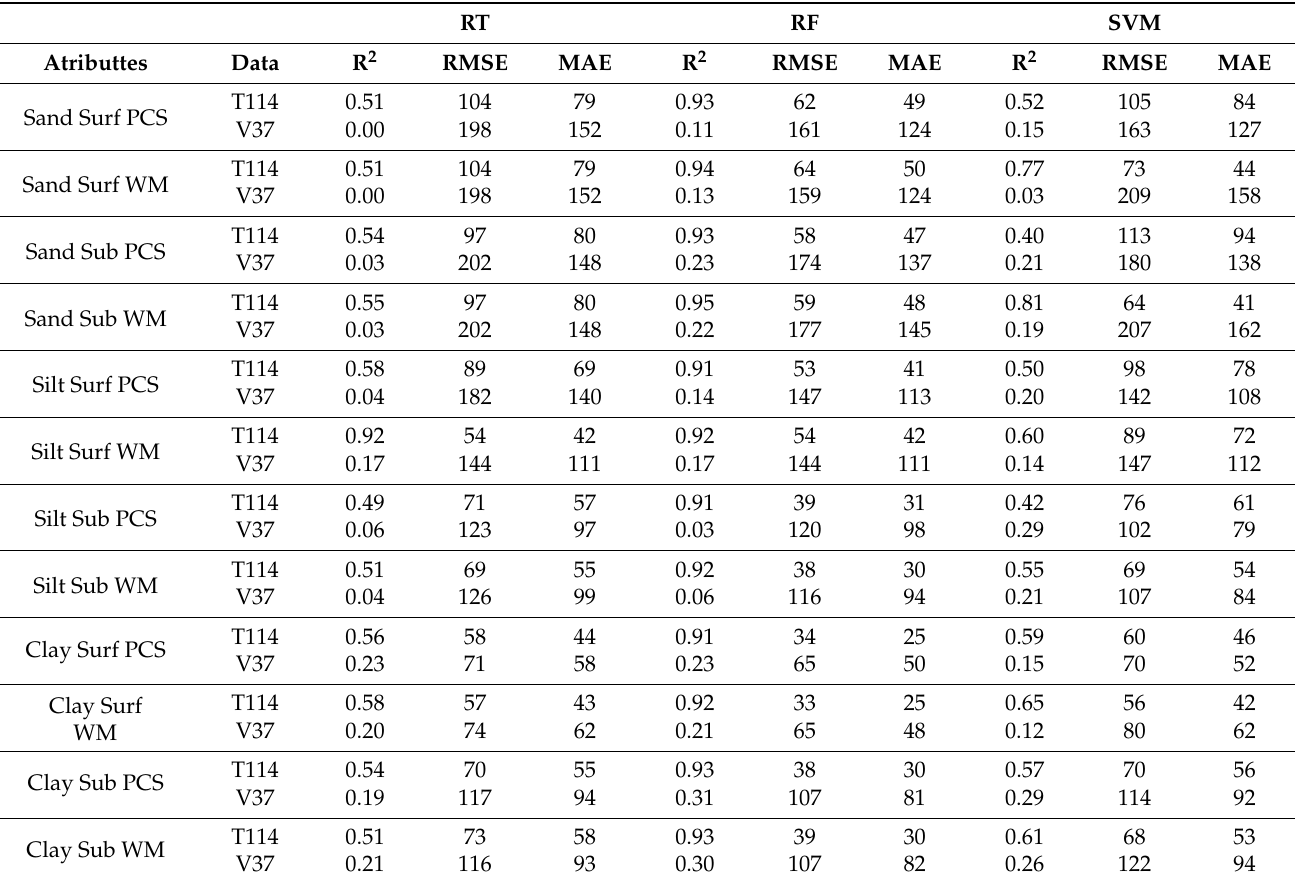
Table 8. Accuracy assessment of soil surface and subsurface sand, silt, and clay content predictions using the Total Area (TA) sampling